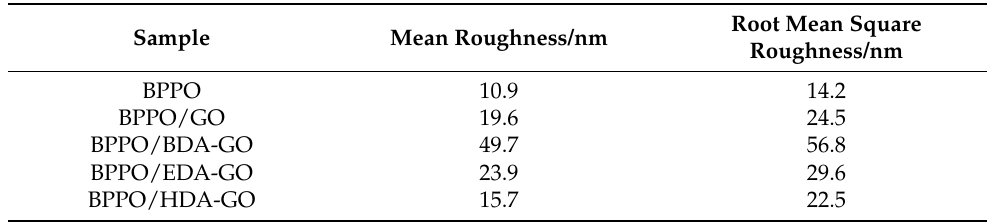
Table 1. Roughness average and root mean square of the BPPO membrane, BPPO/GO membrane, and Ax-GO-modified nanofiltration membranes.